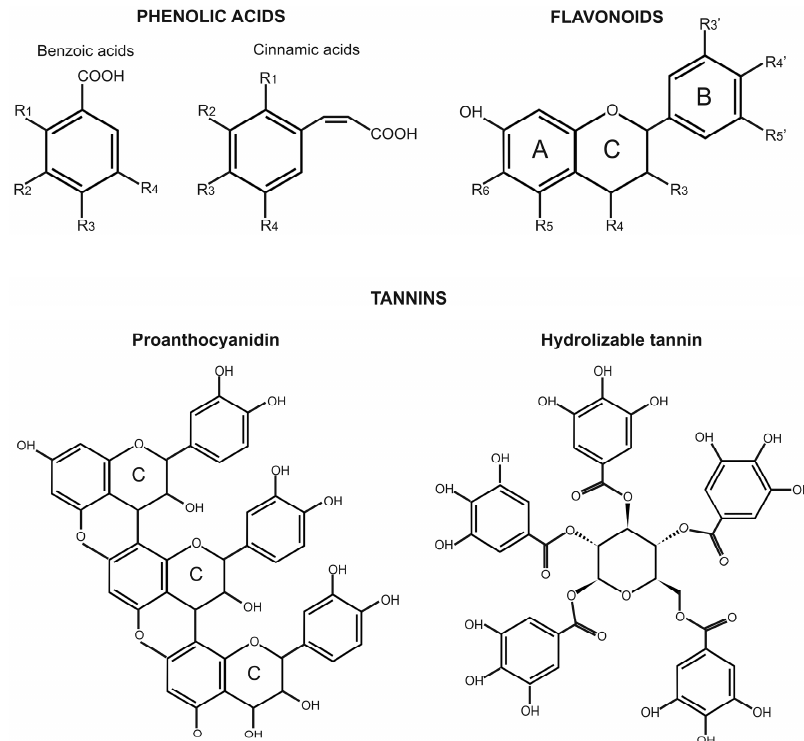
Figure 2. General structures of the three most important classes of phenolic compounds for